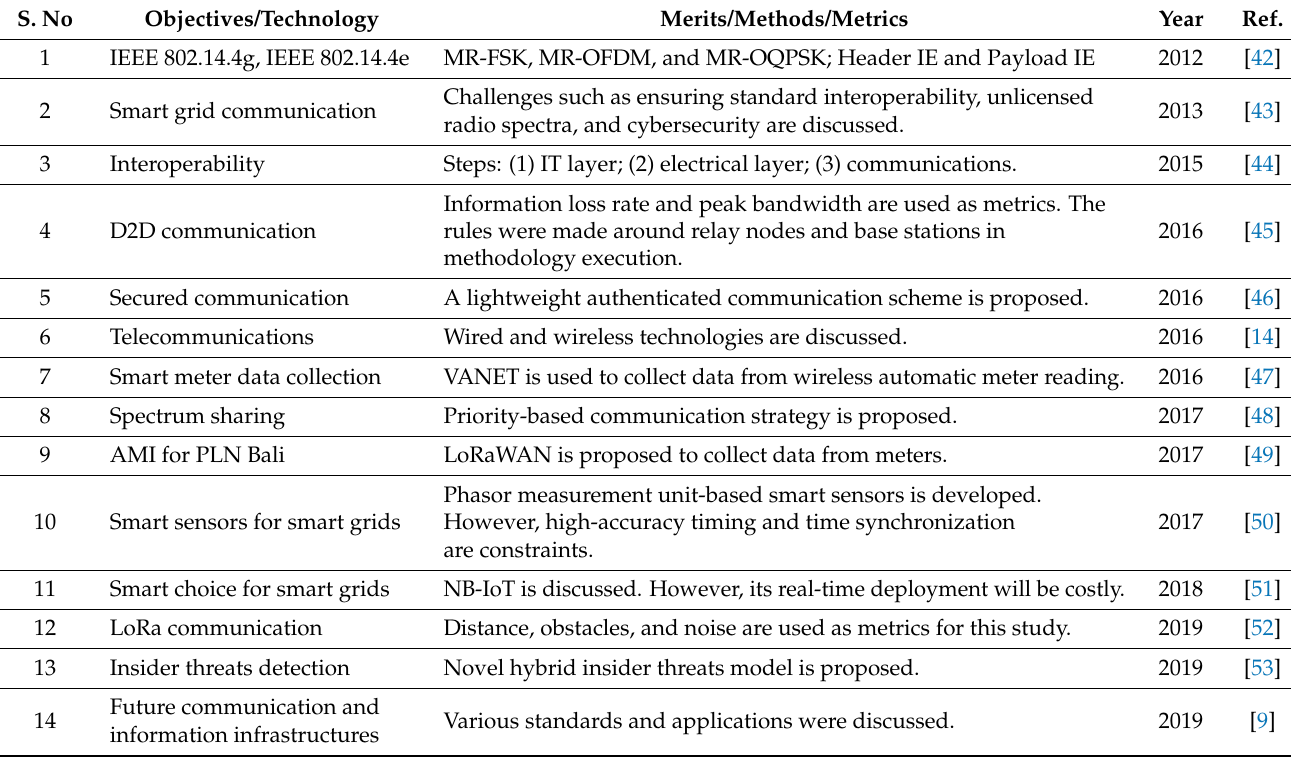
Table 4. State-of-the-art literature works on